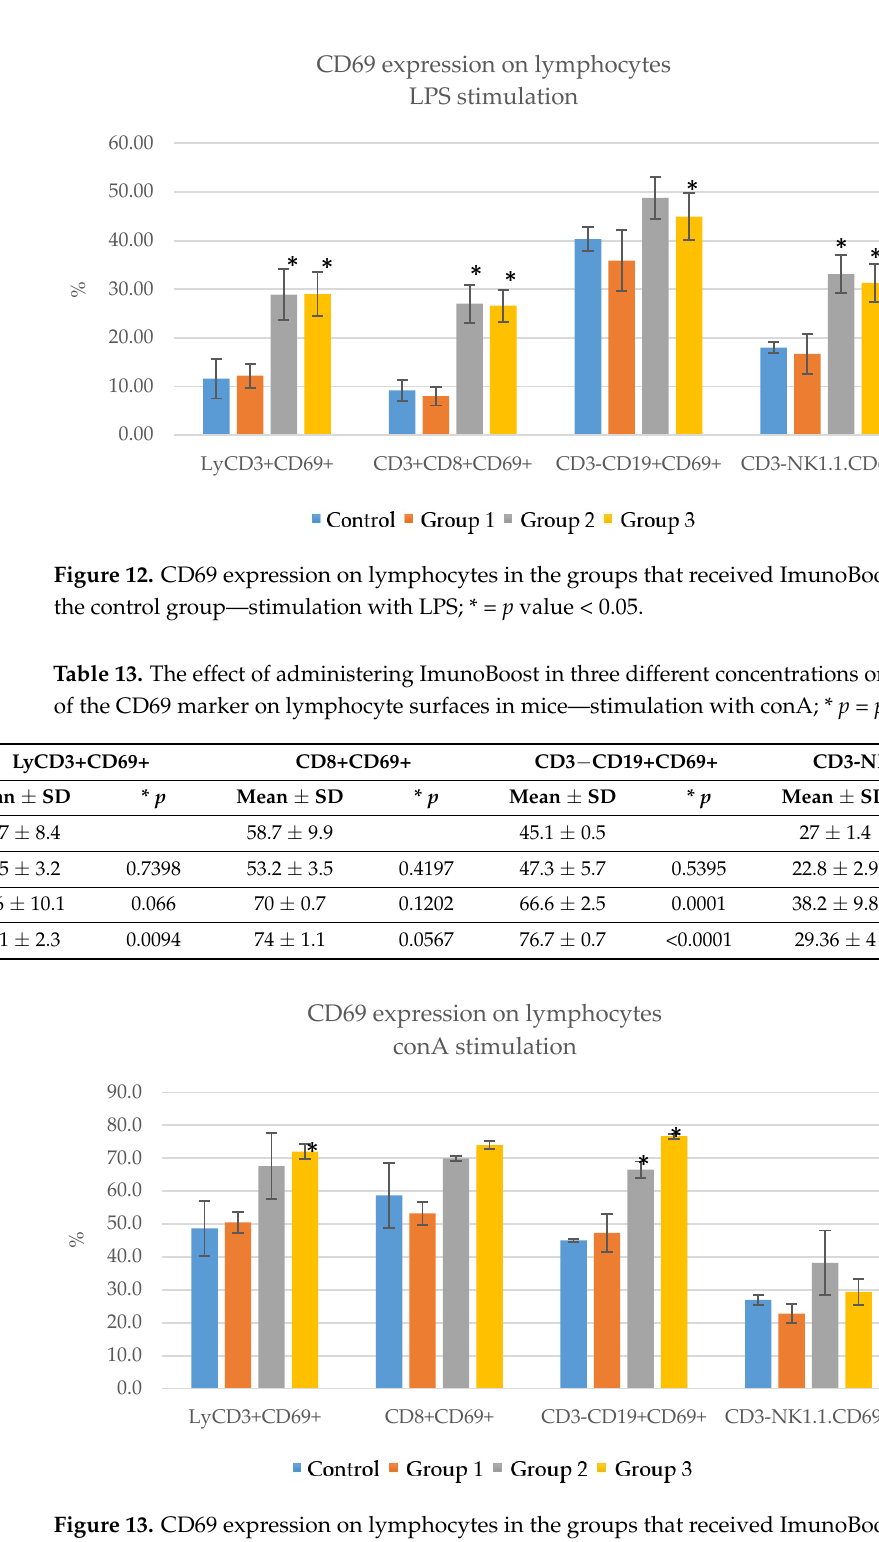
Figure 14. Lymphocyte proliferation capacity in groups that received the novel nutraceutical compared to the control group—stimulation with LPS; * = p value < 0.05. The stimulation of lymphocyte proliferation via modulation with conA showed that the splenocytes isolated from animals receiving the novel nutraceutical at the dose of 200 mg/kg proliferated almost two times more (0.269 ± 0.049) than those from the control group (0139 ± 0.01) (Table 15, Figure 15).